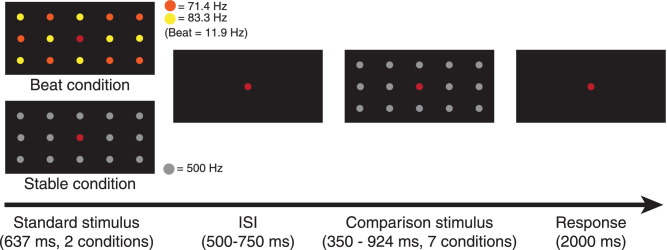
Task schematic and stimulus conditions for Experiment 3. Only the central fixation point was red. Other LED colors are for demonstrative purposes. Stimuli were presented in orange. ISI = inter-stimulus interval.